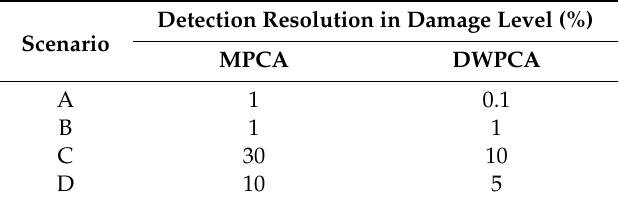
Table 1. Detection resolution of moving principal component analysis (MPCA) and double-window PCA (DWPCA) for di ff erent scenarios.